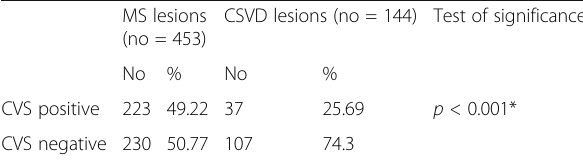
Table 3 Number and percentage of lesion with CVS in MS and CSVD